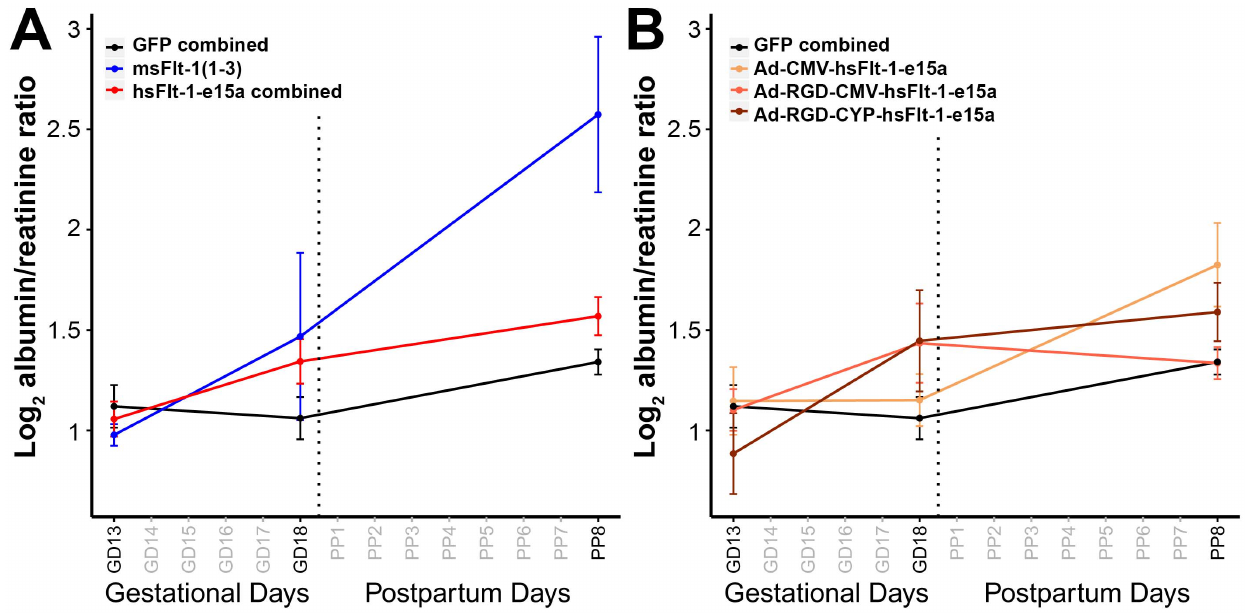
Figure 7. Functional evaluation of the kidneys. ( A ) Chart depicts albumin/creatinine ratios (in log scale) in urine specimens from mice in the GFP, msFlt-1(1-3) and hsFlt-1-e15a-treated groups. Mean urine albumin/creatinine ratios were higher in hsFlt-1-e15a-treated mice (GD18, p=0.04 and PPD8, p=0.03) and msFlt-1(1-3)-treated mice (PPD8, p=4 6 10 2 5 ) than in controls. Proteinuria was extremely high in the mouse overexpressing msFlt- 1(1-3) with chronic hypertension. ( B ) Subgroup analysis showed that hsFlt-1-e15a expressed under the CMV promoter in the adenovirus led to significant increase in albumin/creatinine ratio on PPD8 (p=0.003); hsFlt-1-e15a expressed under the CMV promoter in the fiber-mutant adenovirus led to significant increase in albumin/creatinine ratio on GD18 (p=0.04); while hsFlt-1-e15a expressed under the CYP promoter in the fiber-mutant